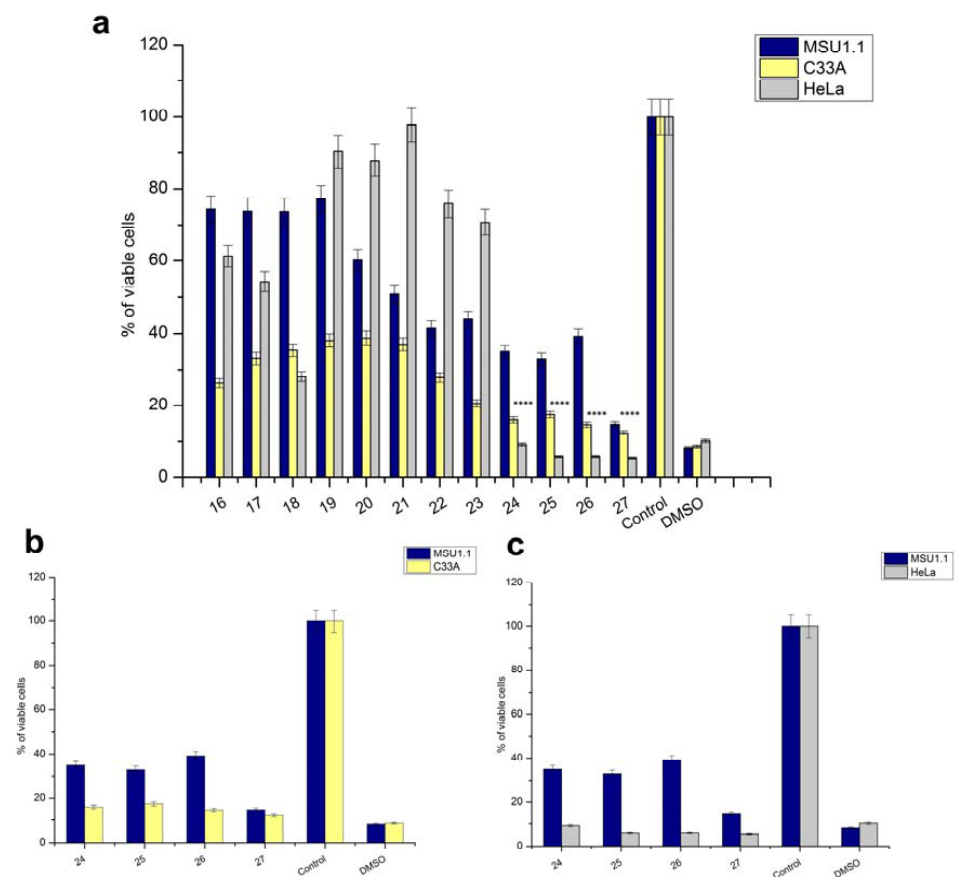
Figure 7. CmMLP1 and the accompanying three alkaloids decreased in vitro viability of human cervical cancer cells (HPV-negative and HPV-positive). ( a – c ) Viability (%) of C33A and HeLa cancer cells compared to that of normal MSU1.1 fibroblasts after treatment with latex fractions for 48 h. Control (negative)—untreated cells; DMSO—positive control. ( a ) C33A, HeLa, and MSU-1.1 cell lines treated with fractions 16–27. ( b ) Both C33A HPV- cervical cancer cell line and MSU-1.1 treated with fractions 24–26 containing CmMLP1 accompanied with alkaloids and fraction 27. ( c ) Both HeLa HPV+ cervical cancer cell line and MSU-1.1 treated with fractions 24–26 containing CmMLP1 accompanied with alkaloids and fraction 27. ****, p <